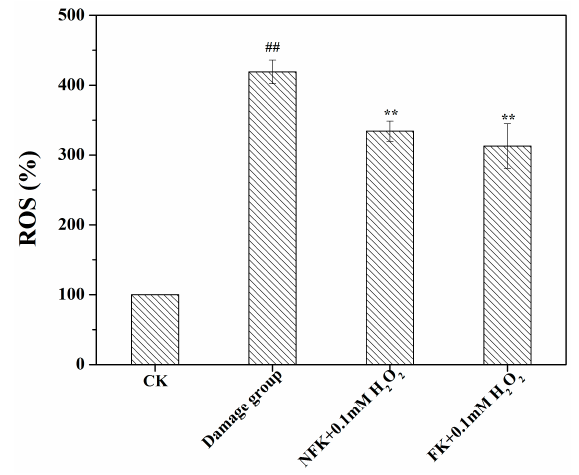
Figure 4. Intracellular ROS level of NFK (10 mg/mL) and FK (10 mg/mL) in PC 12 cells. The fluorescent probe DCFH-DA was used to the cell ROS level. Data are presented as mean ± S.D., ( n = 3). ## p < 0.01 compared with the control cells; ** p < 0.01 compared with the damage group.